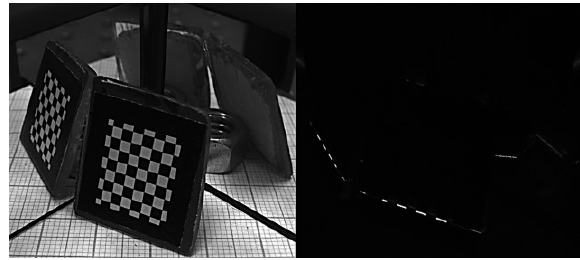
Figure 9: Calibration images with laser off and